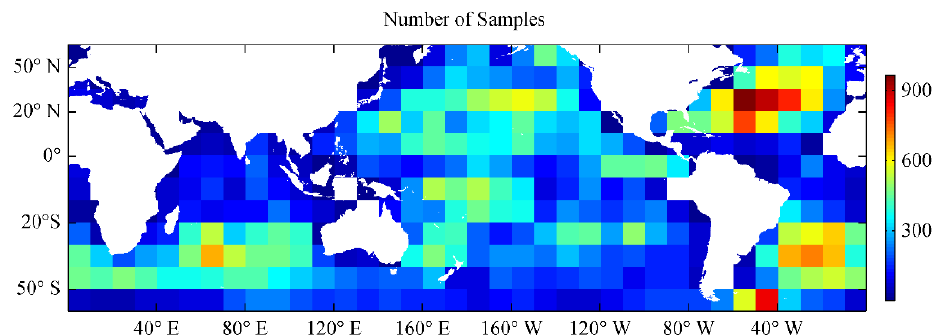
Figure 7. Number of independent SST samples from 2016 in the global ocean within 10° × 10°grids.